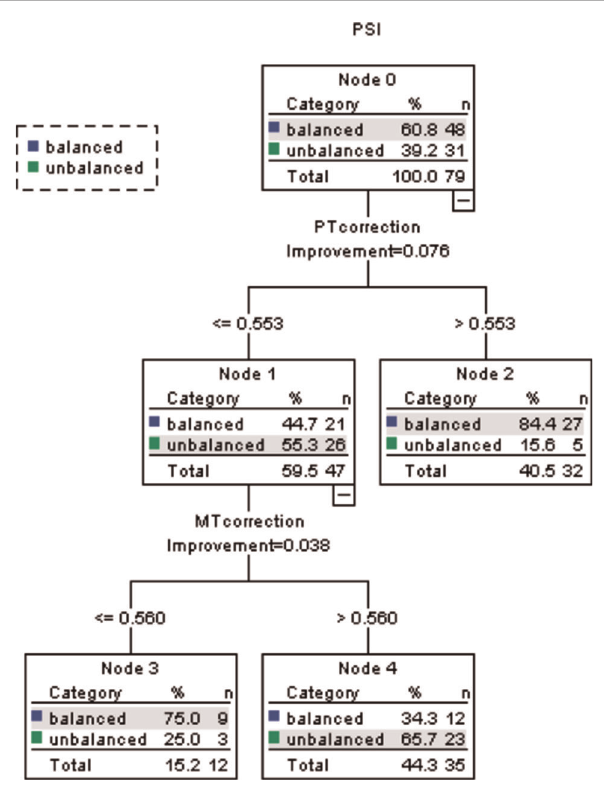
FIGURE 1 | Classi fi cation and regression tree analysis for predicting postoperative shoulder